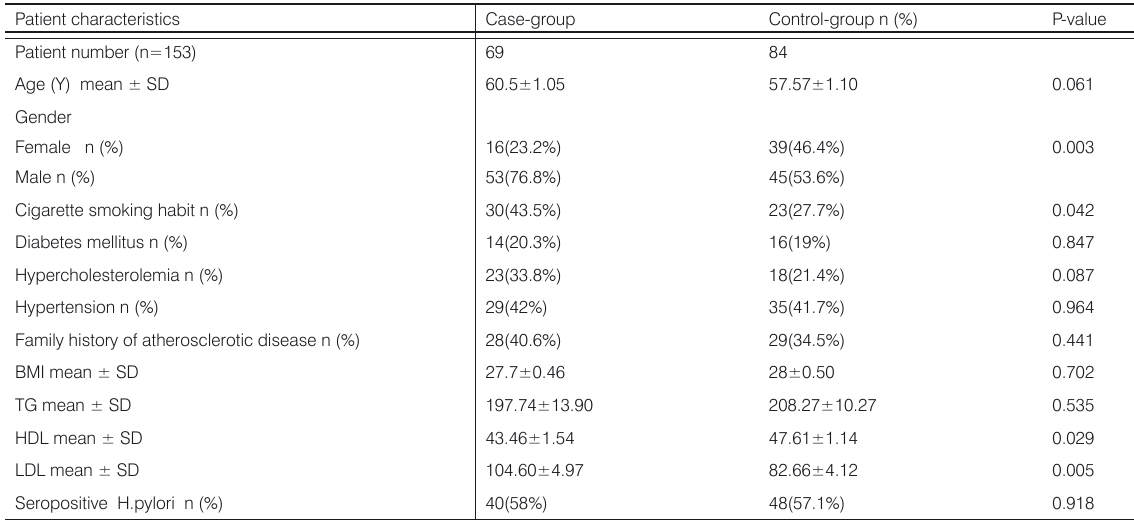
Table 1. Univariate analysis of demographic characteristics and H. pylori infection seropositivity between two